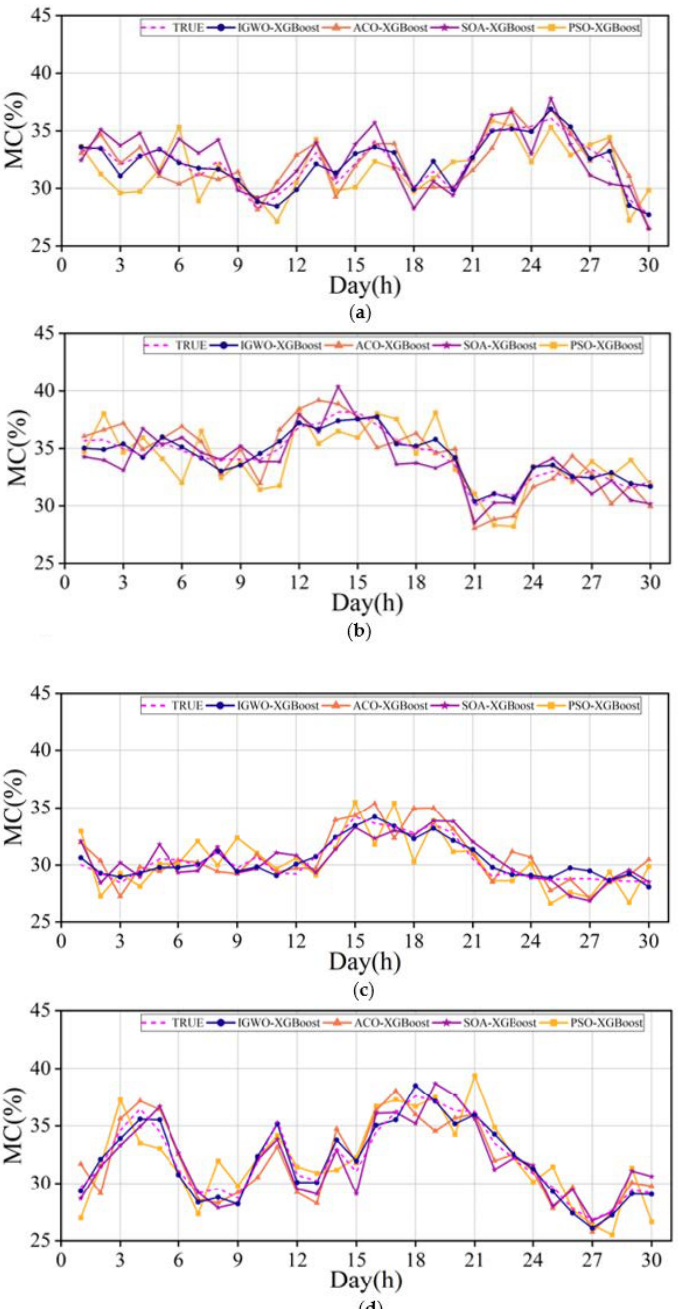
Figure 12. Trunk MC variations of 4 selected trees during 30 days: ( a ) Robinia Pseudoacacia; ( b ) Photinia serrulata; ( c ) Pinus massoniana; ( d ) Toona sinensis.